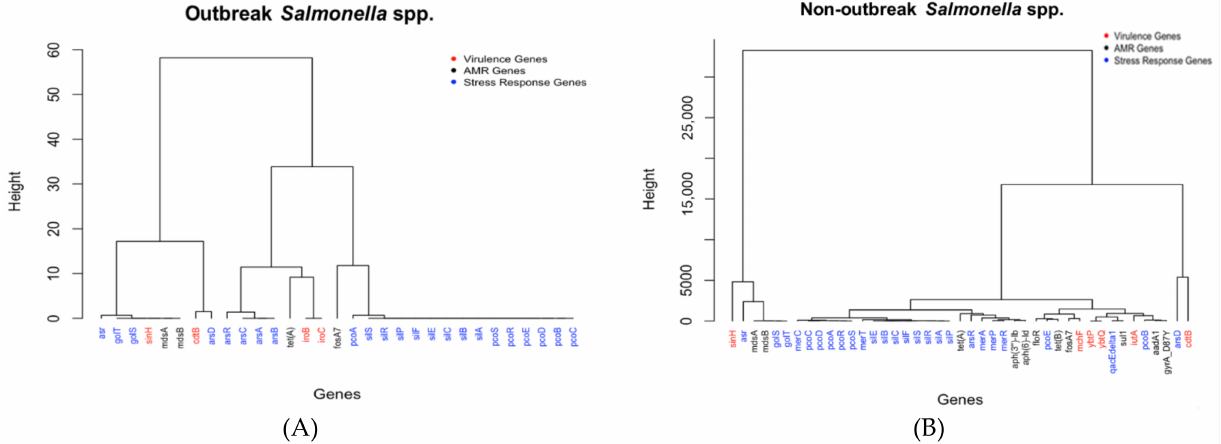
Figure 3. The dendrograms of outlier genes identified for ( A ) outbreak Salmonella spp. isolates and ( B ) non-outbreak Salmonella spp. isolates.